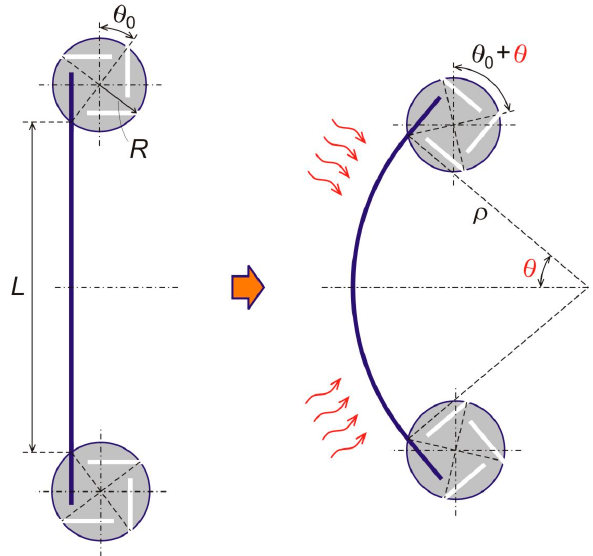
Figure 2. Definition of the chirality angle θ 0 , as a variable system parameter, and special cases of this angle for metamaterials with solid nodes of square, triangular, and circular shapes. ( a ) arbitrary θ 0 , ( b ) θ 0 = 45 ◦ , ( c ) θ 0 = 60 ◦ , ( d ) θ 0 = 90 ◦ .